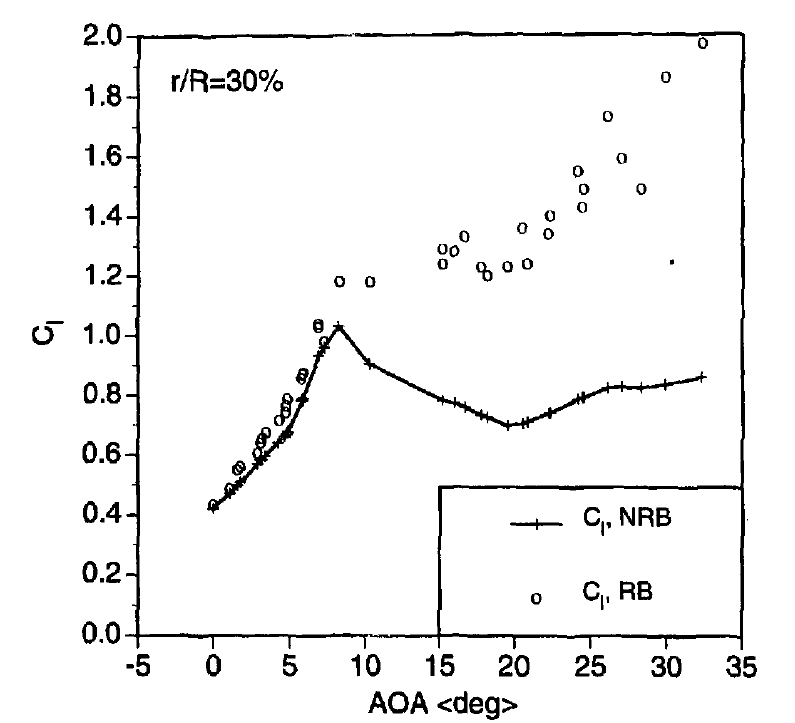
Figure 1. C L vs. AoA for rotating blade (RB) and non − rotating blade (NRB) at 30 percent blade length